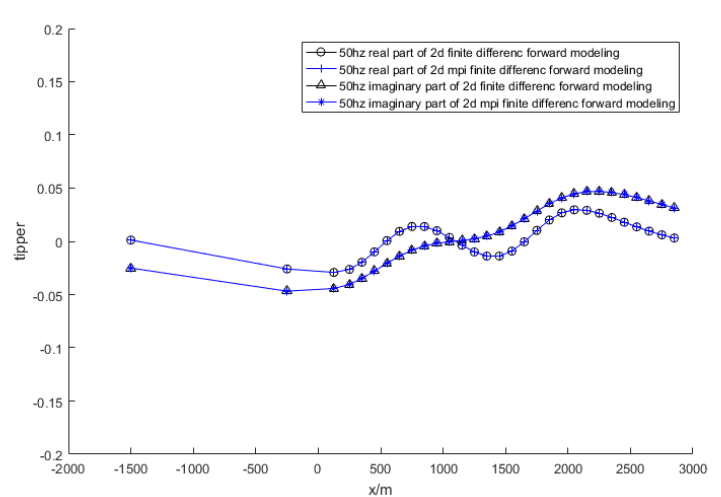
Figure 3. Forward result figure.